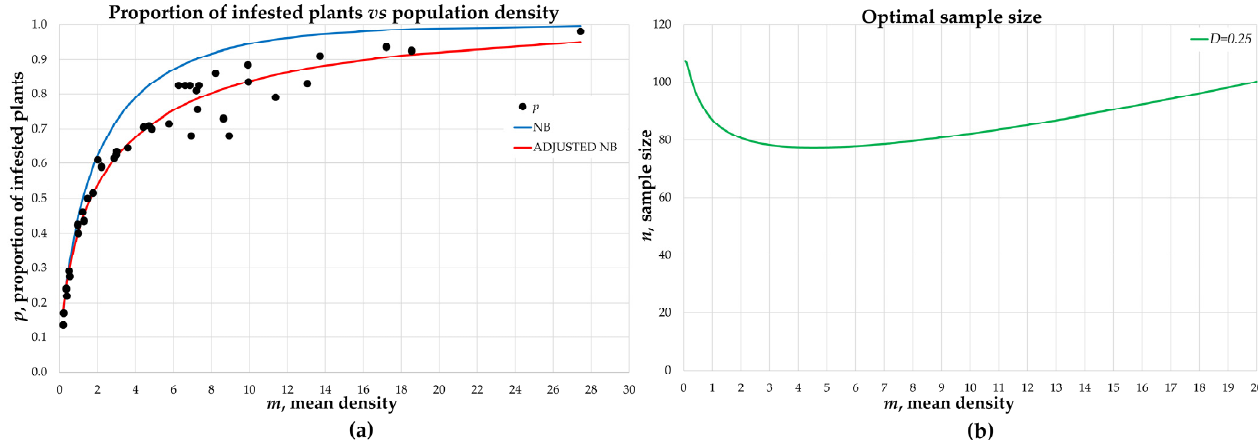
Figure 3. Binomial sampling. ( a ) Relationship between the proportion of infested plants and population density and ( b ) sample size as a function of the average density.